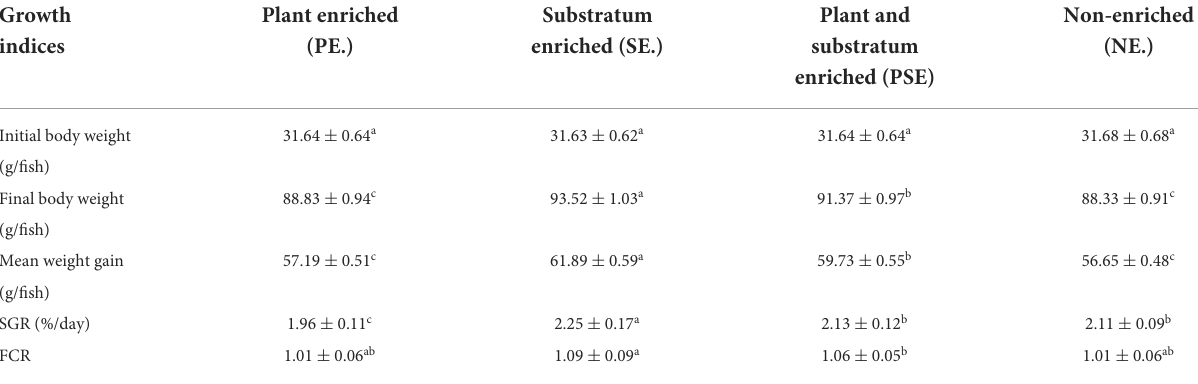
TABLE 2 The growth parameters of C. gariepinus exposed to different forms of environmental enrichment under laboratory conditions. Growth indices